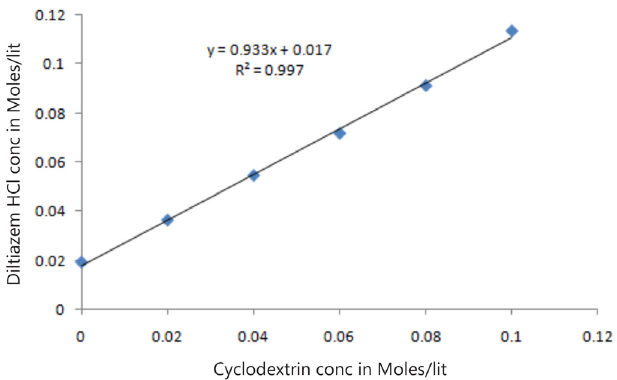
Crospovidone Sodium starch glyolate Aspartame Magnesium stearate Ice cream flavor